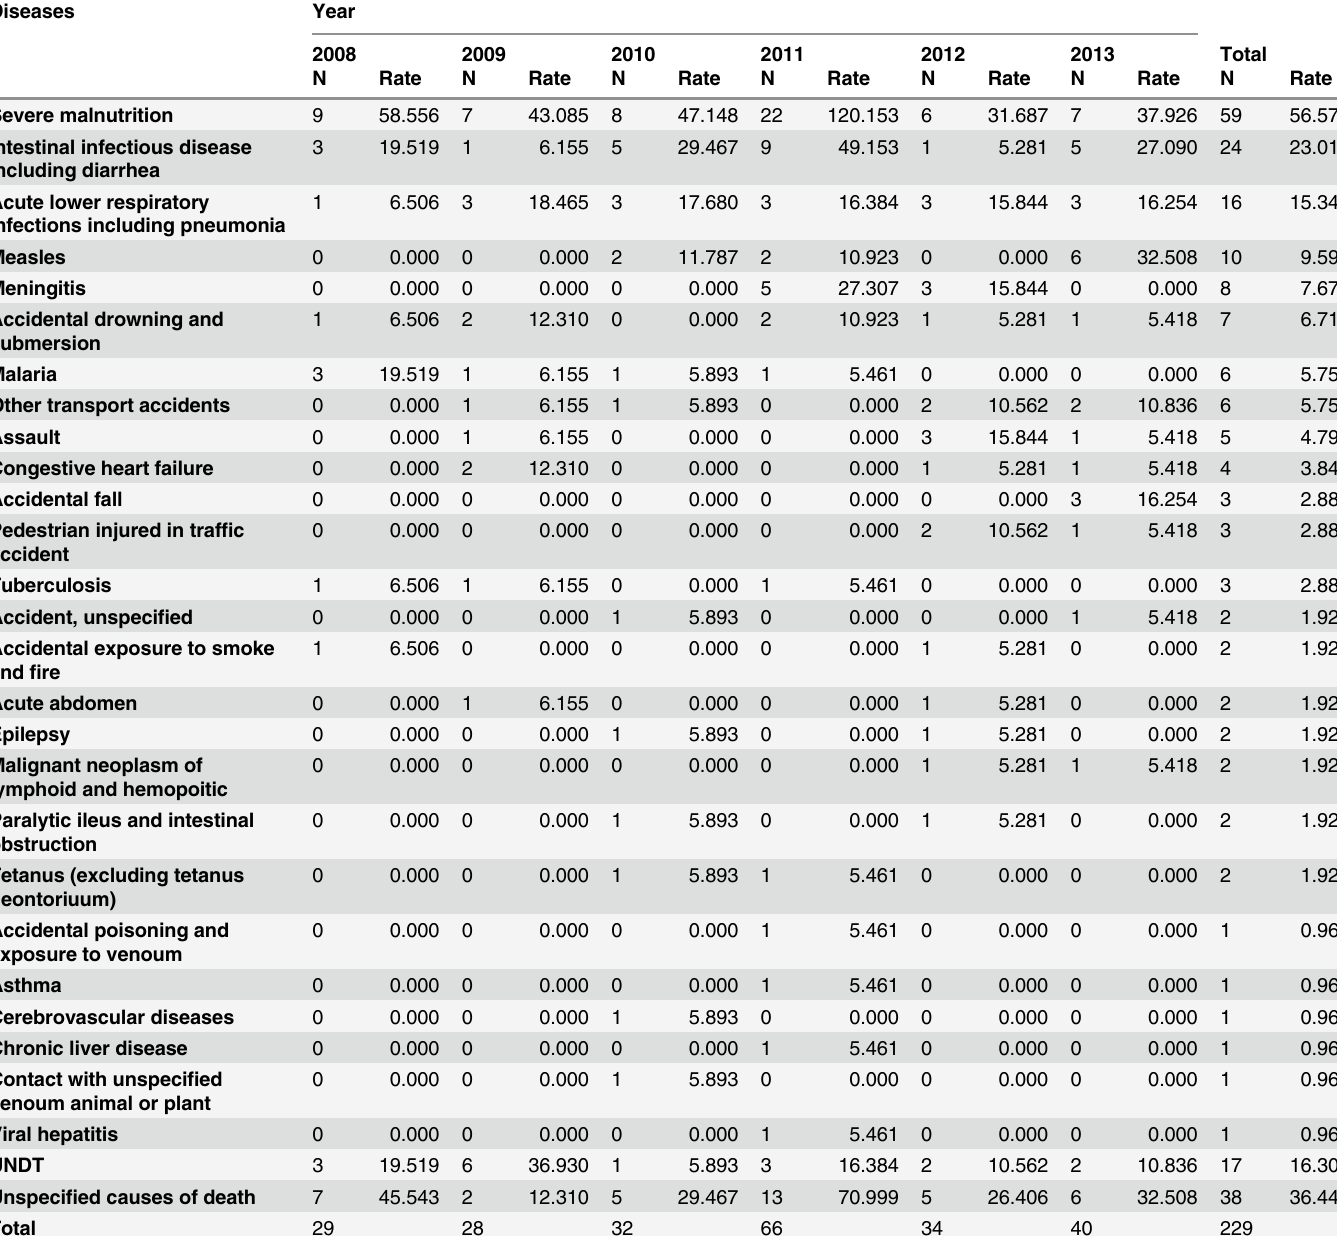
Table 4. Cause Specific Death rates per 100,000 populations for major causes of death by year among children aged 5 to 14, Kersa HDSS, 2008 – 2013.